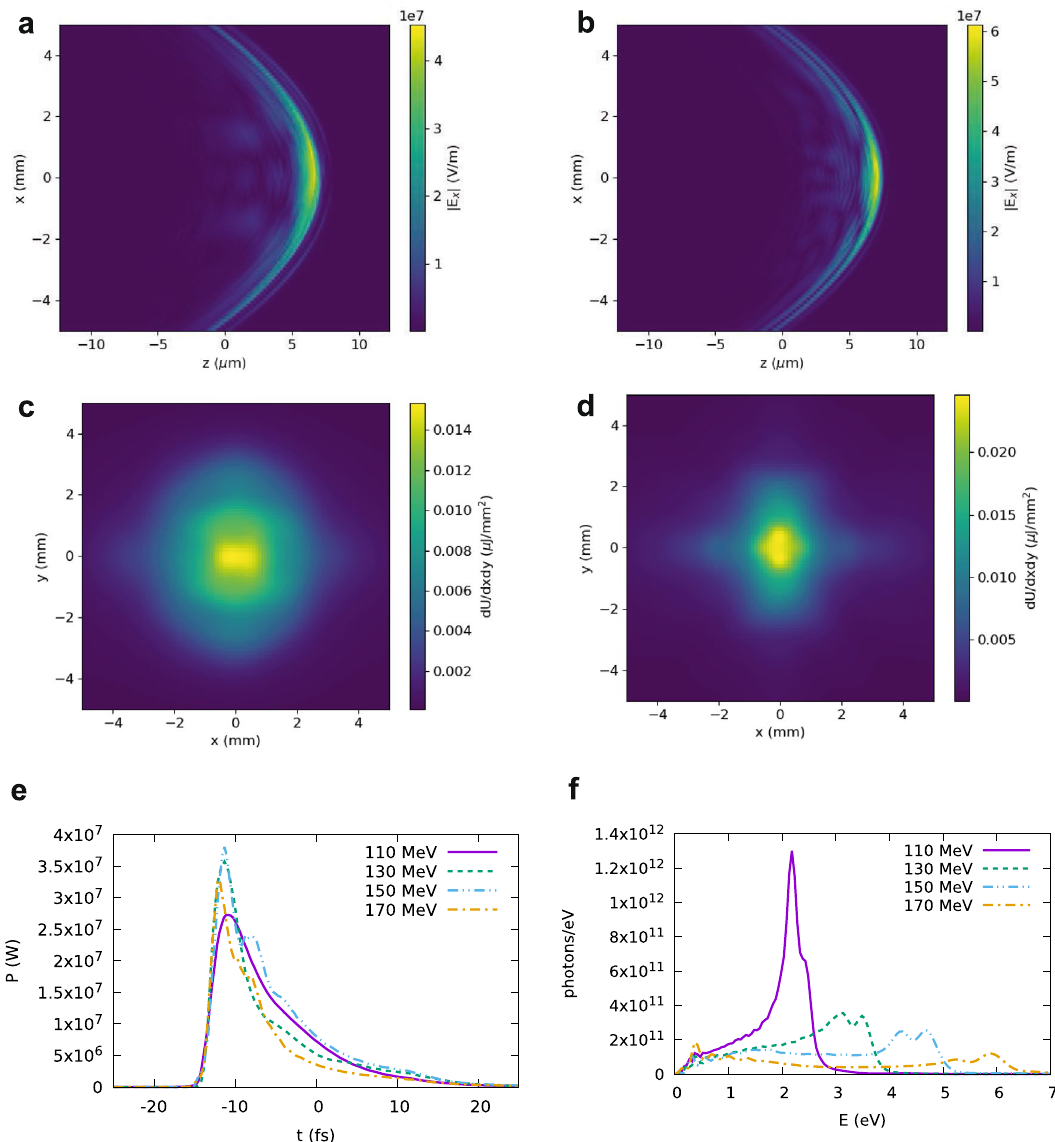
Figure 8. Undulator radiation obtained using GPT for a LWFA modelled using the particle-in-cell code FBPIC. ( a ) Electric field generated for 110 MeV mean energy and ( b ) 130 MeV mean energy. ( c ) Spatial distribution generated for 110 MeV mean energy and ( d ) 130 MeV mean energy. ( e ) Power and ( f ) spectrum for four electron beam energies. Radiation is calculated 1 m from the undulator exit in a 10 mm × 10 mm